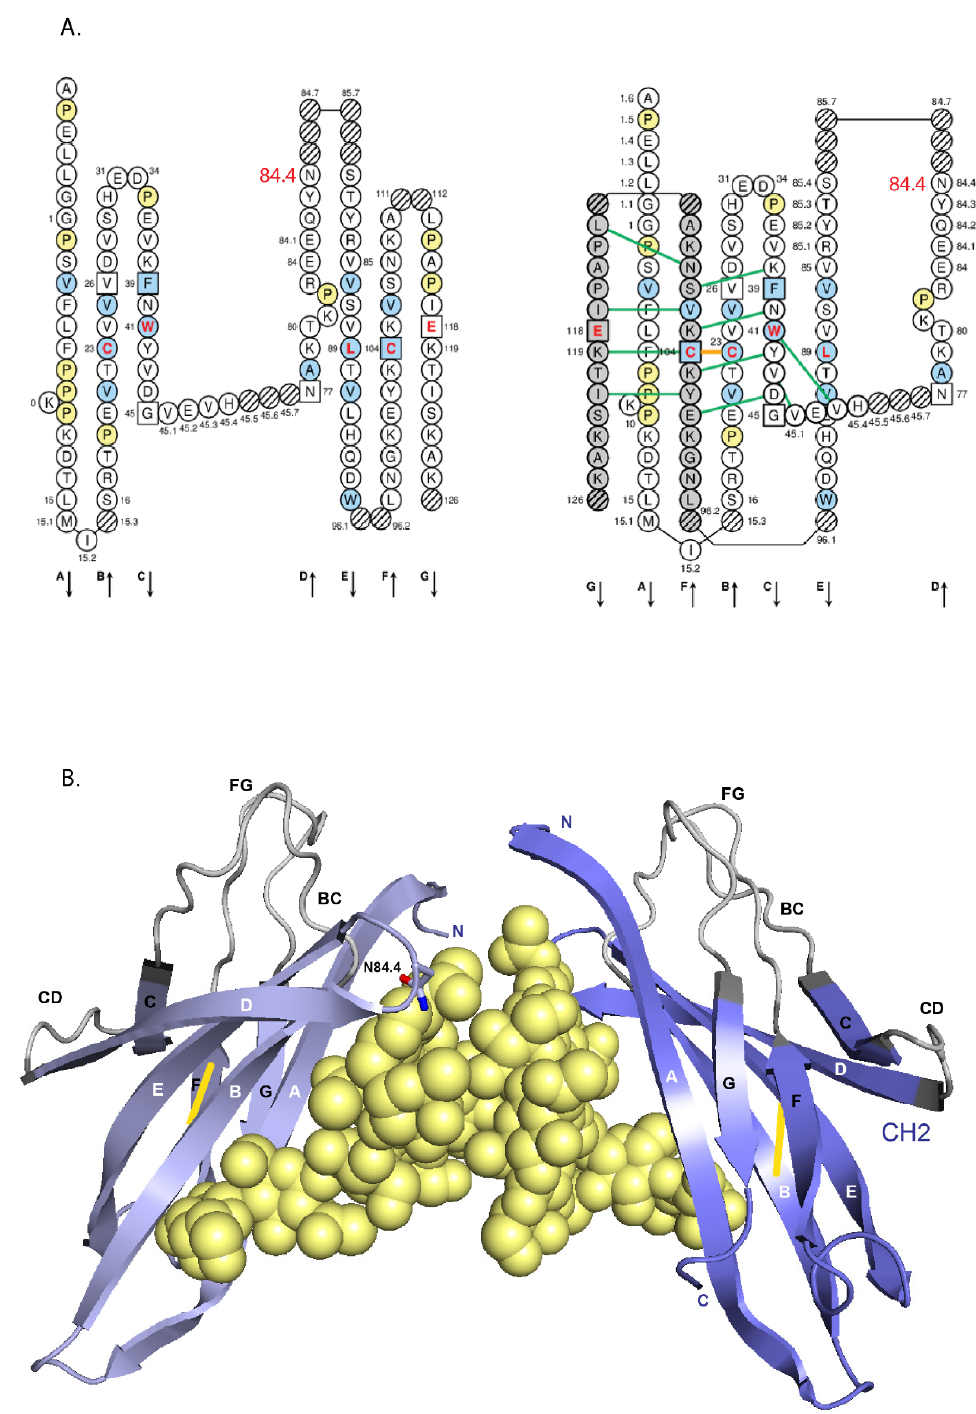
Figure 35. Homo sapiens IGHG1 CH2 and N-linked glycosylation site N84.4 [94]. ( A ) IMGT Collier de Perles of IGHG1 CH2 on one layer (on the left) and on two layers with hydrogen bonds (on the right). The N84.4 is at the DE turn. The identifier of the chain to which the domain belongs is 1hzh_H. The IMGT Colliers de Perles on two layers show, in the forefront, the GFC strands and, in the back, the ABED strands, linked by the CD transversal strand. The IMGT Colliers de Perles were generated by the IMGT / Collier-de-Perles tool [51] integrated in IMGT / 3Dstructure-DB [57–59]. Hydrogen bonds (green lines) and disulfide bond between C23 and C104 (orange line) were automatically added from the experimental structural data). Amino acids are shown in the one ‐ letter abbreviation. Positions at which hydrophobic amino acids (hydropathy index with positive value: I, V, L, F, C, M, A) and tryptophan (W) are found in more than 50% of analysed sequences are shown in blue. All proline (P)